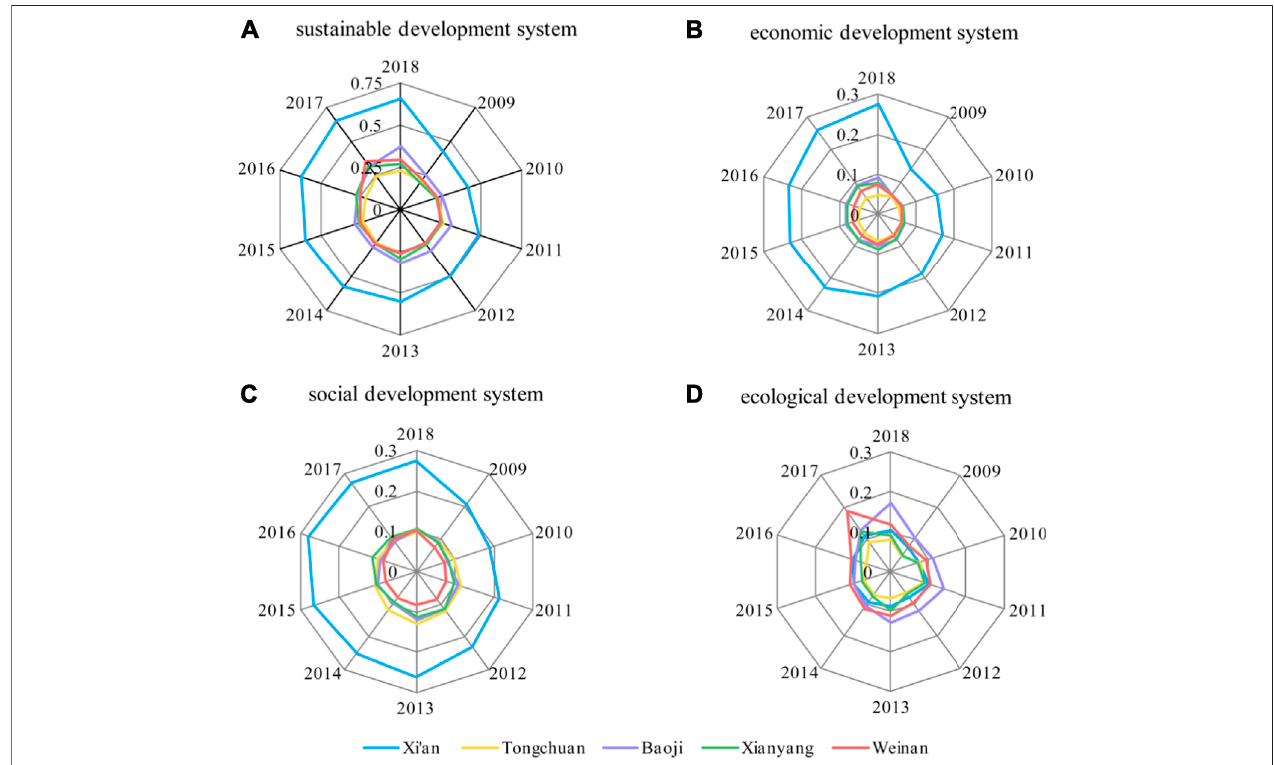
FIGURE 3 | The evaluation value of river basin sustainable developmentby score-radar maps (A) sustainable development, (B) economic development, (C) social development, and (D) ecological development.